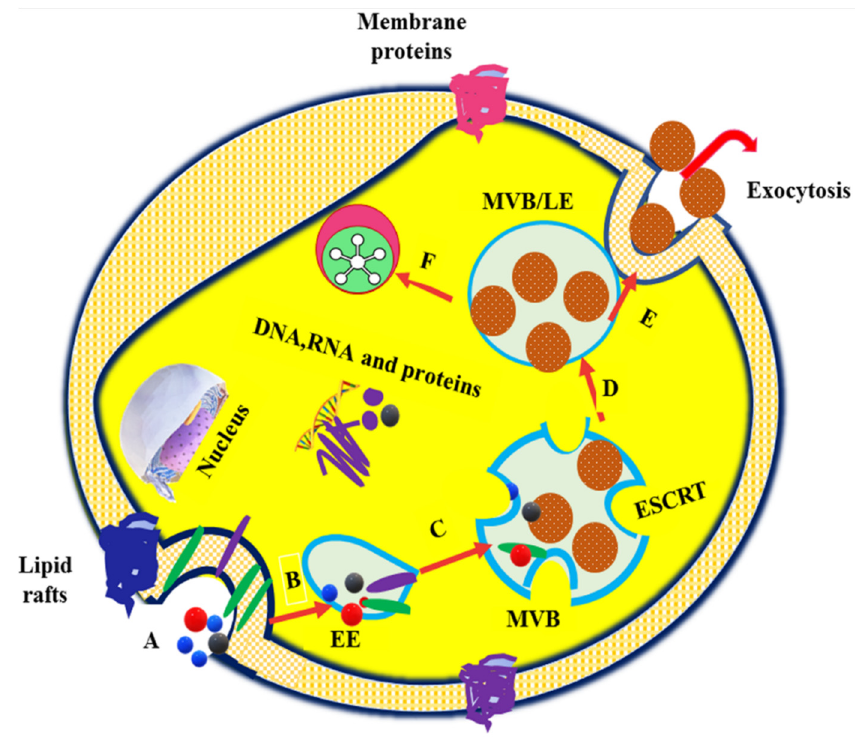
Figure 1. Exosome vesicle formation, cargo sorting (starts from endocytosis and ends in the MVBs), and release. ( A ). Endocytosis of the plasma membrane ( B ) Uptake of proteins, nucleic acids, and membrane-associated molecules into encysted body and formation of EE. ( C ) Transformation of early endosomes (EE) into multivesicular bodies (MVB) or late endosomes (LE), intraluminal vesicle (ILV) formation via inward budding of MVB or LE, and cargo sorting through ESCRT- and ESCRT-independent pathways. ( D ) Fusion of MVB or LE with the plasma membrane and lysosome. ( E ) Exocytosis of exosomes in response to MVB–plasma membrane interactions. ( F ). Degradation of MVB or LE by the lysosome (modified from [14]).